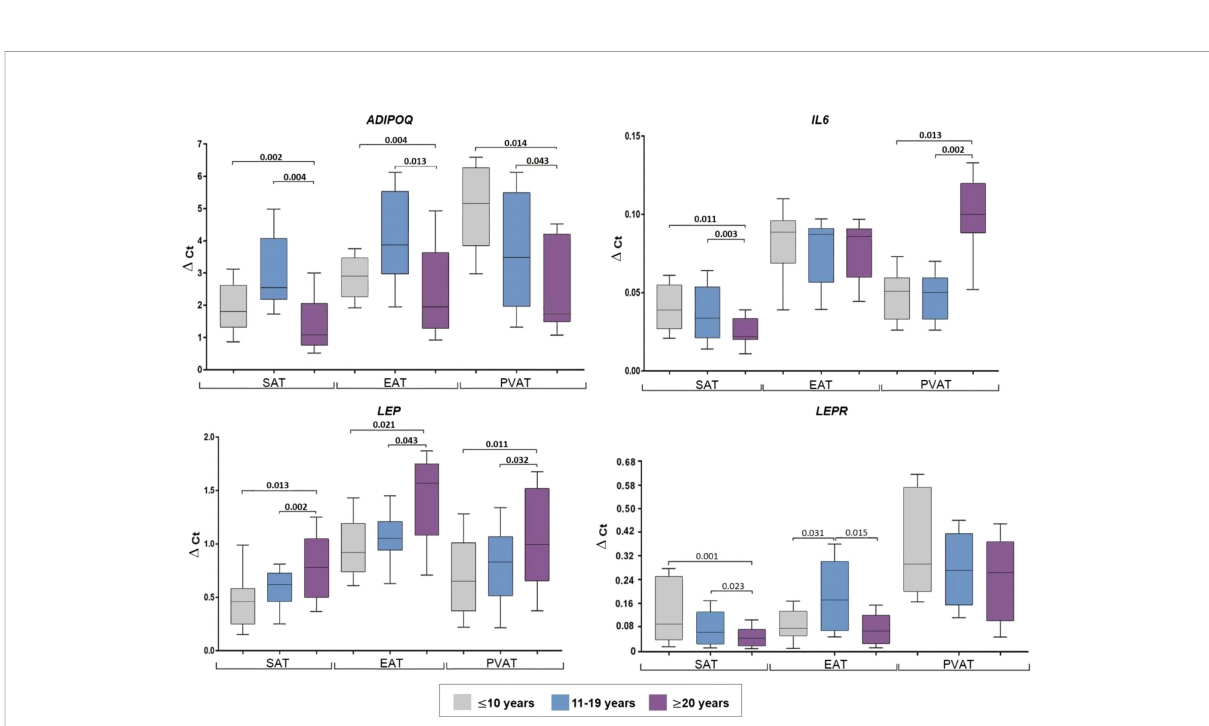
FIGURE 5 Adipocytokine genes expression in the subcutaneous, epicardial, and perivascular adipocytes based on duration of arterial hypertension in patients with coronary artery disease. Data are presented in Me (Q1; Q3). SAT, subcutaneous adipose tissue; EAT, epicardial adipose tissue; PVAT, perivascular adipose tissue; p, level of sta-tistical signi fi cance; sOB-R, soluble leptin receptor; IL6, interleukin